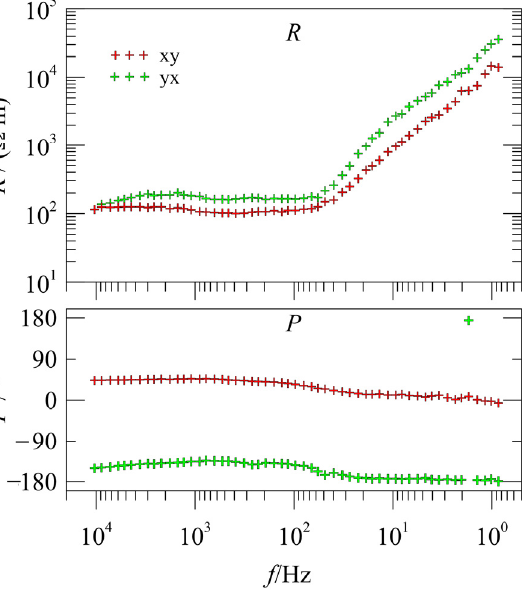
Figure 19. The apparent resistivity ( upper panel) and phase ( lower panel) of the raw data in the Luzon ore district.